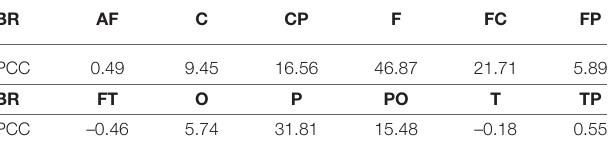
TABLE 2 | Inter-BR FC with PCC.